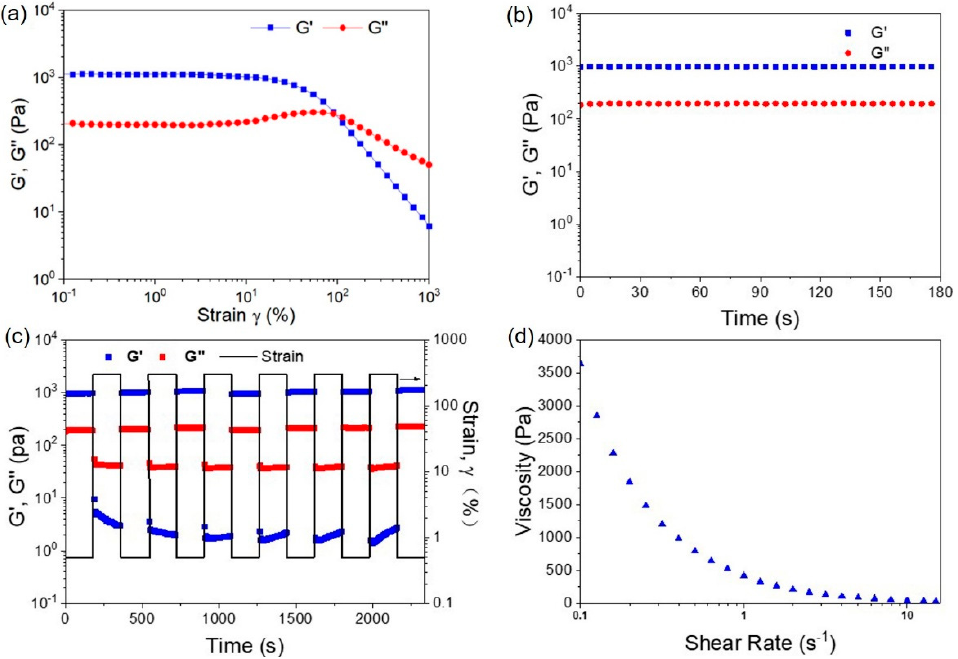
Figure 3. Rheological characterization of obtained hydrogel: ( a ) strain-sweep measurements; ( b ) an immediate recovery after the 1000% strain deformation; ( c ) dynamic strain amplitude cyclic test ( γ = 0.5% or 300%); ( d ) viscosity measurement.